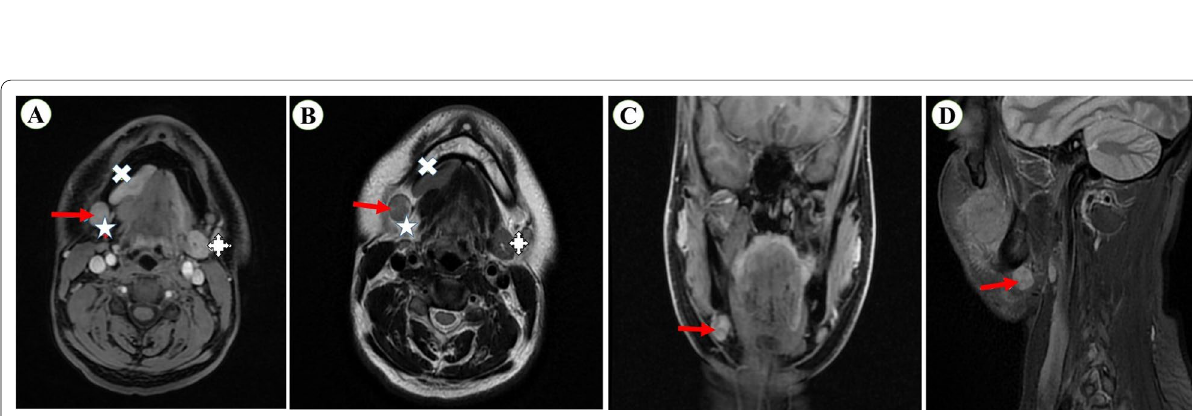
Fig. 3 MRI— A A single well-defined rounded homogeneously enhancing lymph node noted in the right submandibular region (right level IB) (red arrow— A , B , C , D ). This mimics as right submandibular gland. B T2W axial image, linear high signal seen in left submandibular gland due to ducts. The right submandibular gland was absent in right submandibular region (star— A , B ). The left submandibular gland was normal (quad arrow callout— A , B ). The right sublingual gland was showing hypertrophy (cross— A , B )